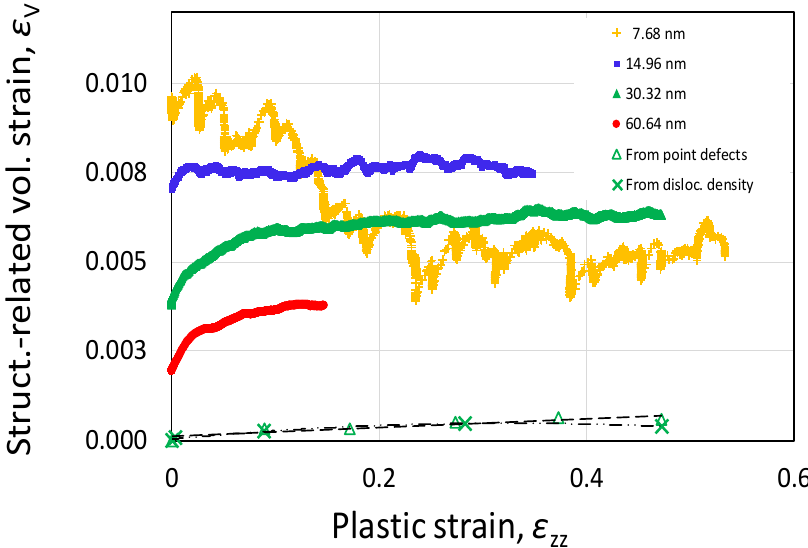
Figure 4. Evolution of the volume strain of the samples relative to the perfect crystal volume (their initial axial lengths are indicated in the figure). The contribution from changes of density of dislocations and point defects inside the grains of the sample of initial length ( L z ) 0 = 30.3 nm is shown in the figure too (see Supplementary Material).